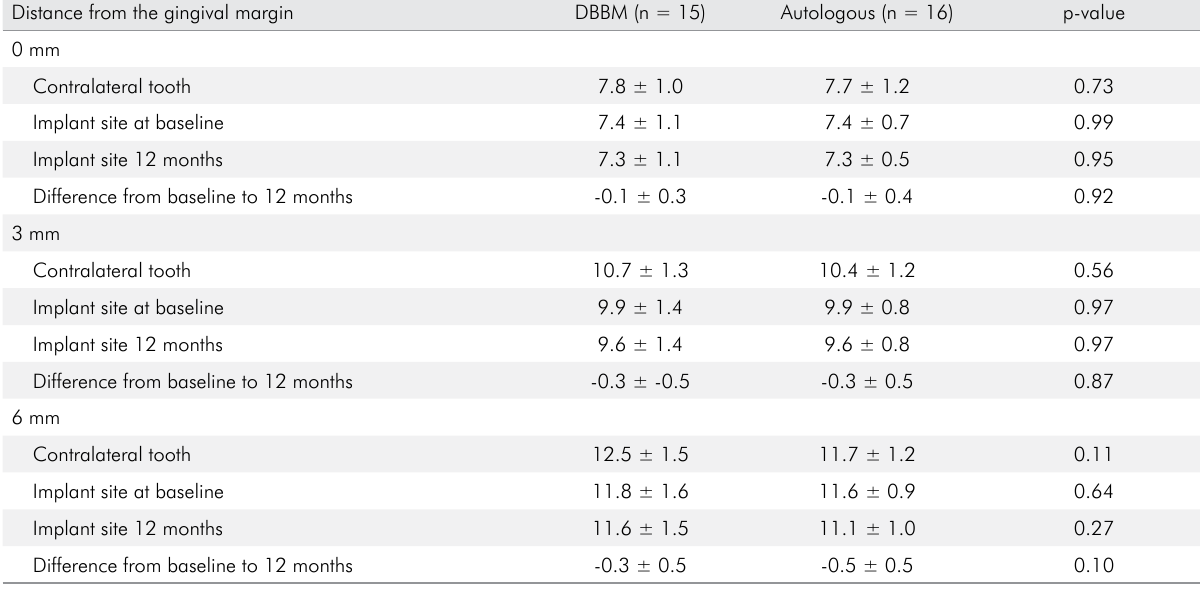
Table 2. Facial-palatal ridge thickness (FPT), in millimeters, in autologous bone block and DBBM groups at the implant site and at the contralateral tooth measured at three different distances from the free gingival margin.